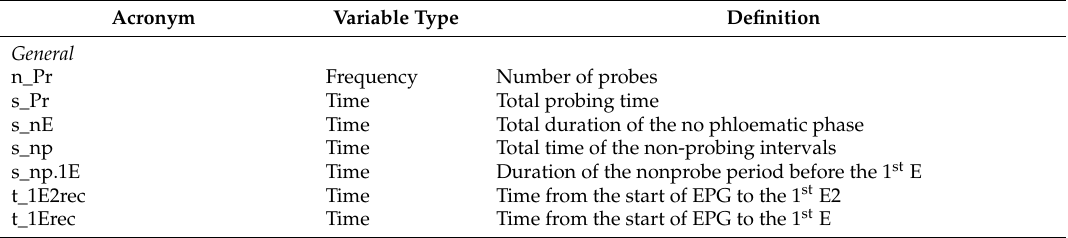
Table 1. The definitions of the waveforms scored in the electropenetrography (EPG)